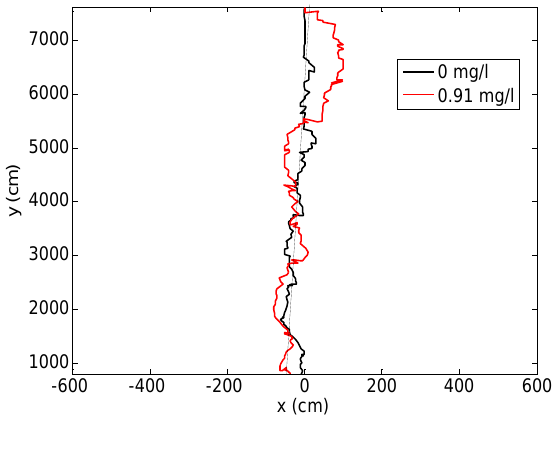
Figure 12. Details of two walking trajectories for different breath alcohol concentration: Woman